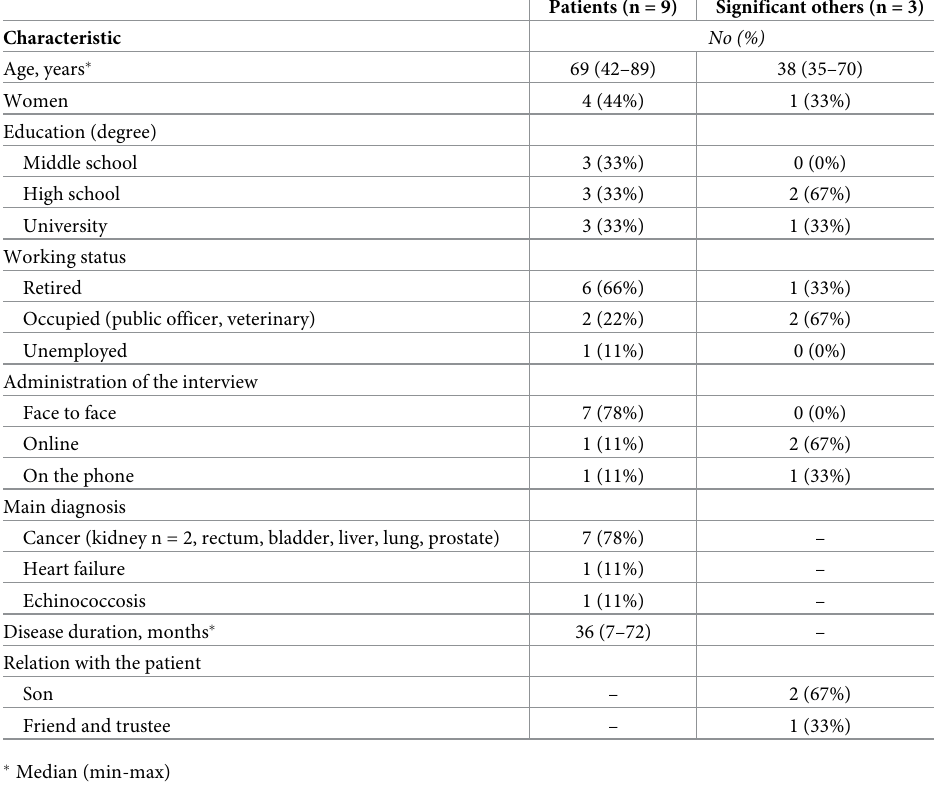
Table 3. General and clinical data of participants in the cognitive debriefing. One of the nine patients was not interviewed (she left the study after partial completion of the Quality of Communication